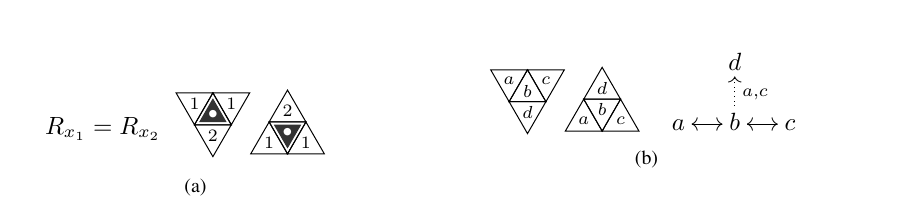
Figure 11: (a) A (2 , 4) priority strategy for the breaker for T 4 , 3 . (b) Dependency digraph of the cells in the orientations of T 4 , 3 .